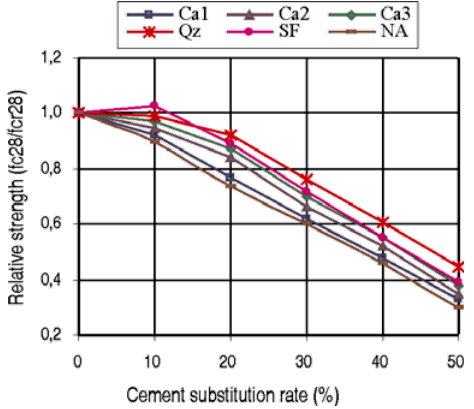
Fig 5. Effect of the cement substitution by mineral